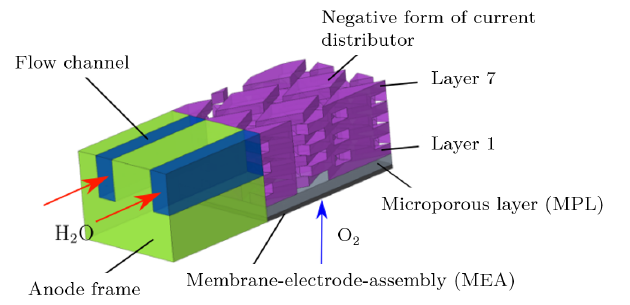
Figure 4. Negative form of a small segment of the PTL for Model